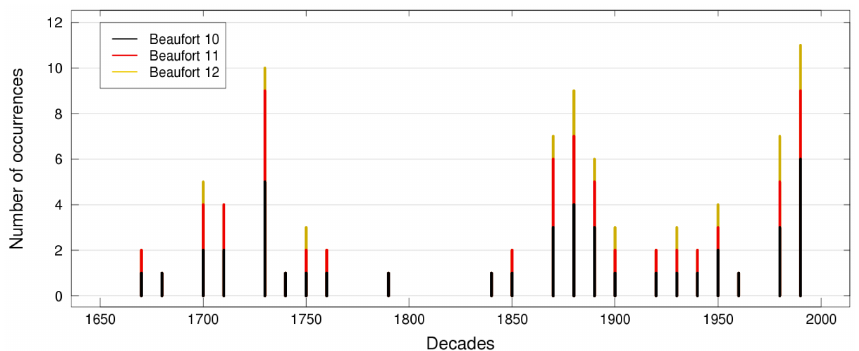
Figure 4. Count of storm occurrences per decade in France from the FR-Garnier-350 data set, split into three damage severity